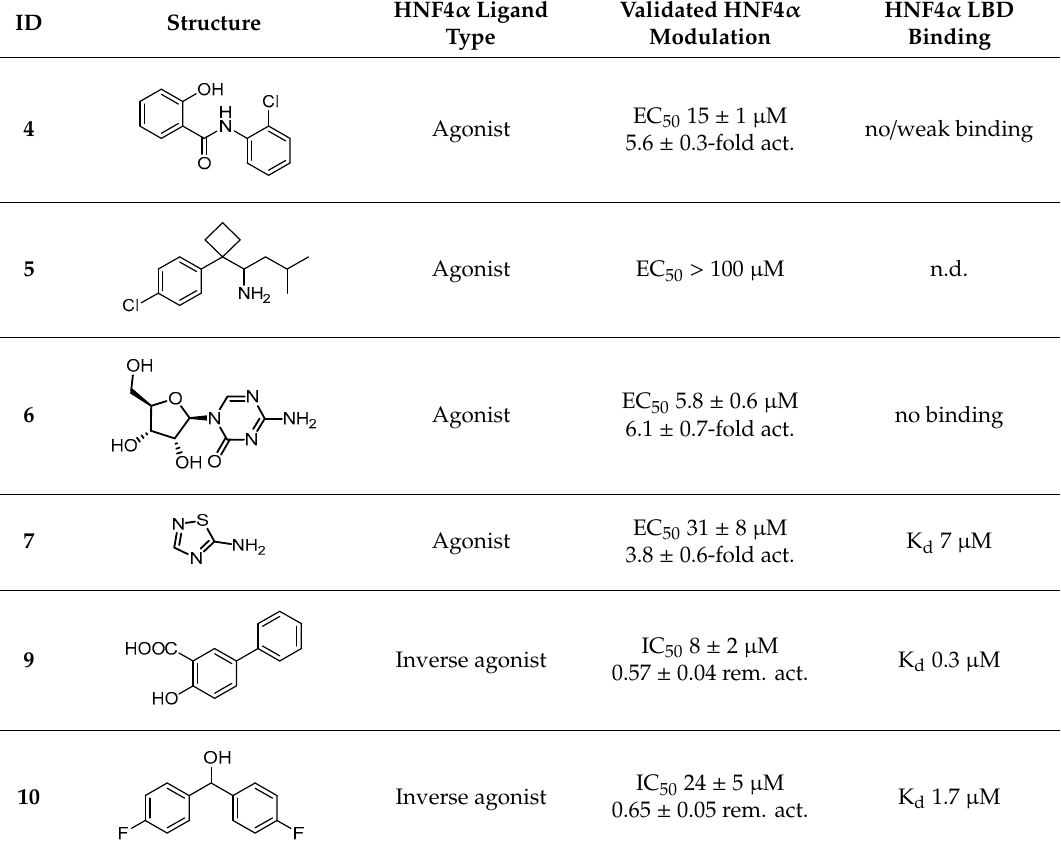
Figure 3. In vitro characterization of HNF4 α modulators 4 , 6 , 7 , 9 , and 10 . ( a ) Dose–response curves of 4 , 6 , 7 , 9 , and 10 on Gal4-HNF4 α (mean ± S.E.M.; n ≥ 4). ( b ) Effects of 4 , 6 , 7 , 9 , and 10 on mRNA expression of fructose-1,6-bisphosphatase 1 (FBP1) in human hepatocytes (HepG2). HNF4 α activators 4 , 6 , and 7 promoted FBP1 expression, while the inverse HNF4 α agonists 9 and 10 decreased FBP1 mRNA levels. Data are the mean ± S.E.M. mRNA levels determined by qRT-PCR and analyzed by the 2 - ΔΔ Ct method; n = 3. ( c ) Control experiments on Gal4-VP16 (boxplots show mean, min.-max.; n ≥ 4). ( d ) Chemical structures of 4 , 6 , 7 , 9 , and 10 . * p < 0.05, ** p < 0.01, *** p < 0.001 ( t -test).